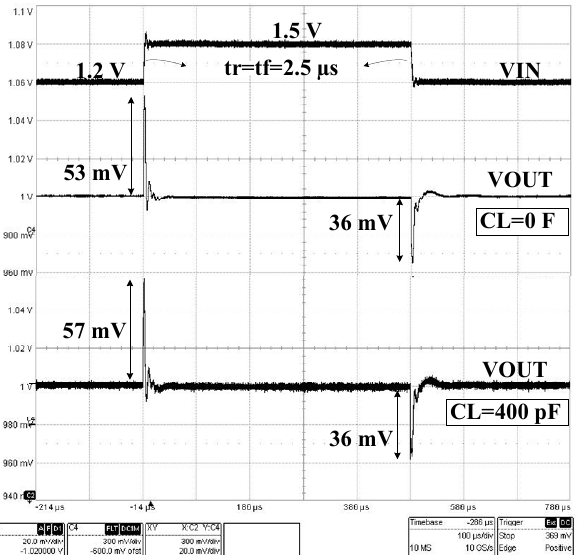
Figure 21. Measured LDO response to a line step for CL = 0 and 400 pF and IL = 1 mA; VIN jumps between 1.2 V and 1.5 V in 2 µ s.